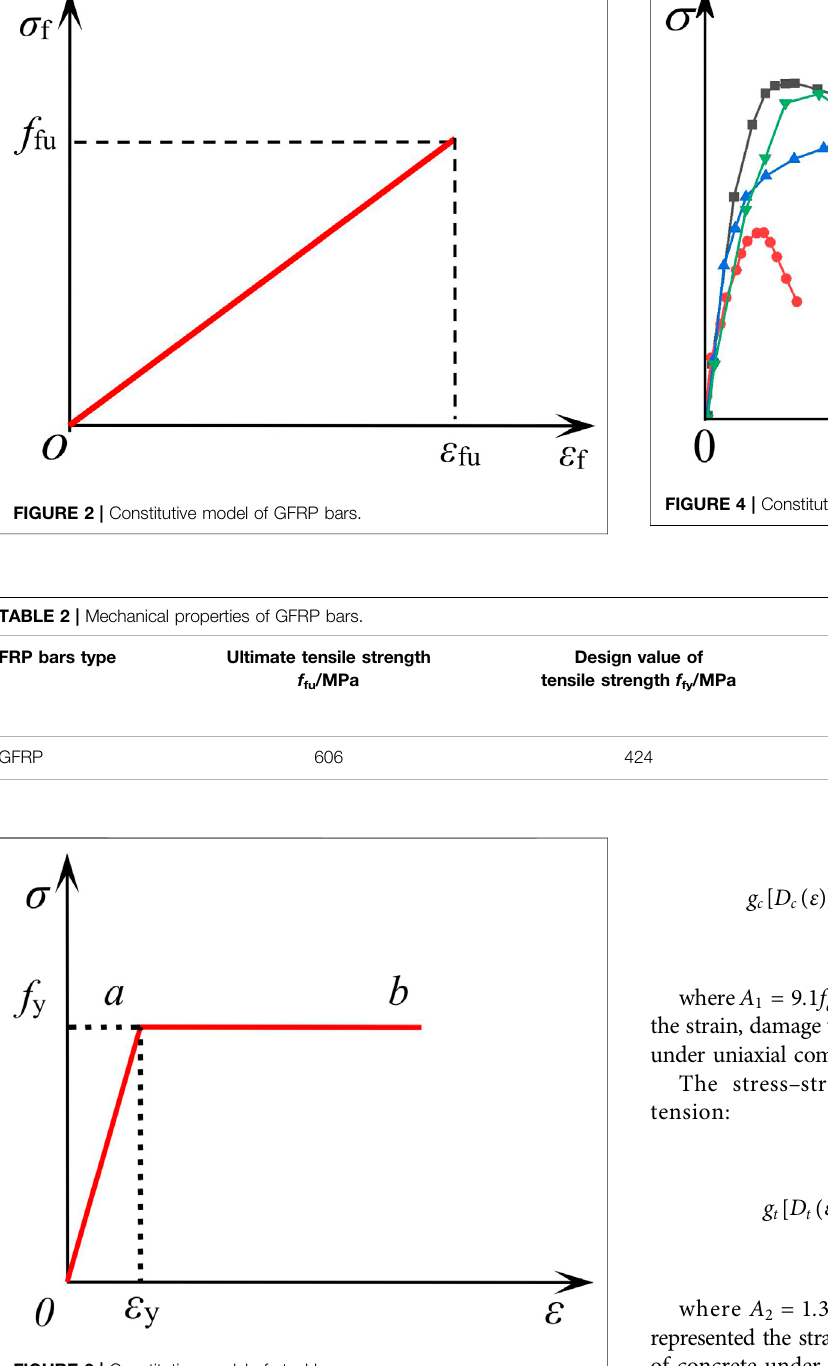
FIGURE 3 | Constitutive model of steel bars.